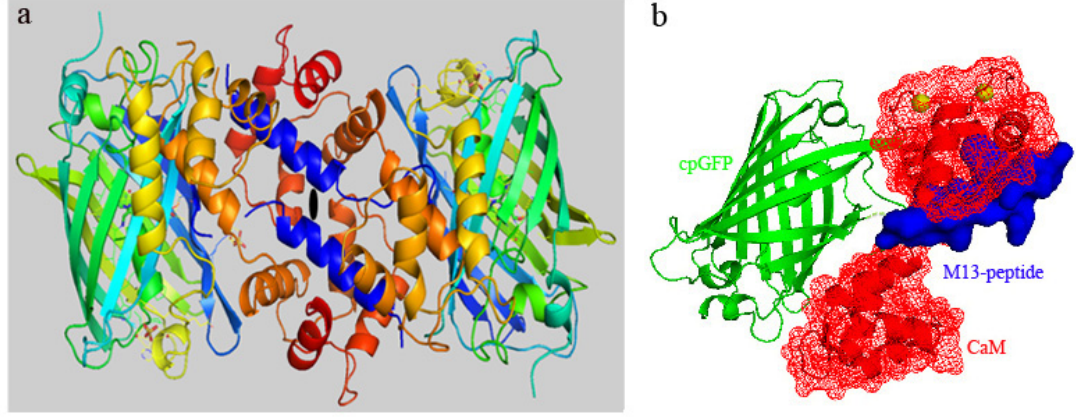
Figure 1. Schematic representation of Case16 structure A. (a) Case16 crystallized as a monomer in the asymmetric unit (in rainbow coloring mode: N-terminus blue, C-terminus red). The crystallographic contact between C-terminal lobes of CaM of the two Case16 molecules is a result of a packing interaction rather than a binding interaction. (b) Domain representation of Case16 structure A. M13-peptide is colored blue, cpGFP is green and N- and C-terminal lobes of CaM are shown red. Ca 2+ ions are shown as yellow